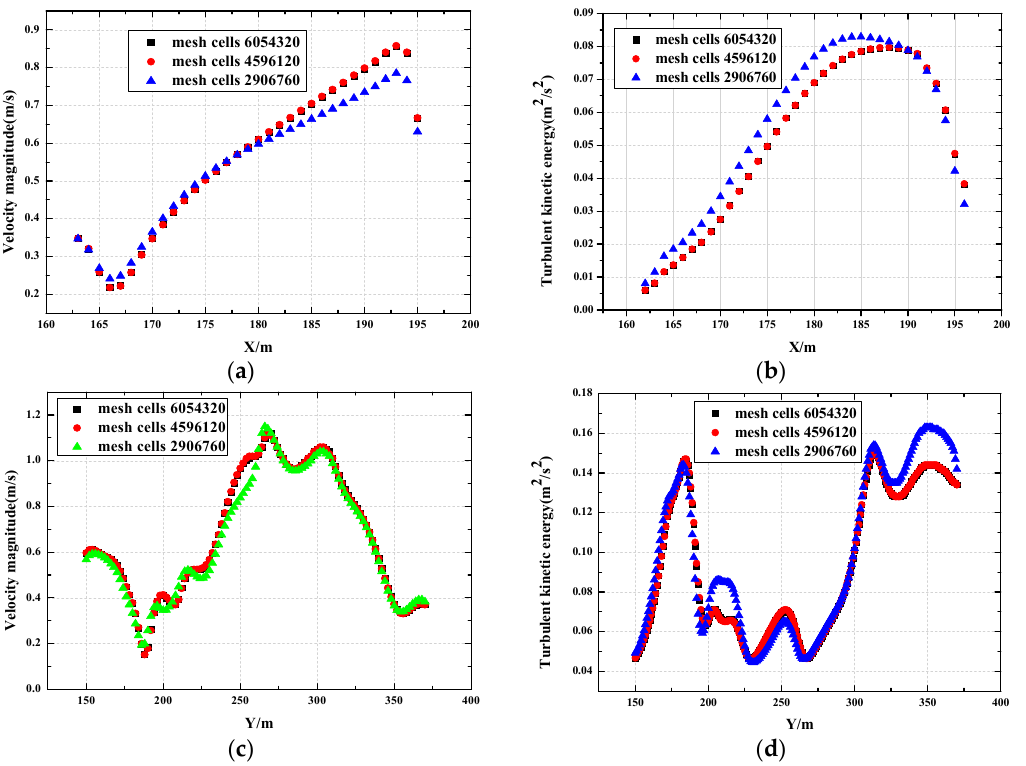
Figure 4. Velocity magnitude and turbulent kinetic energy profile at a height of 2 m along the Y = 160 m section and the street centerline. ( a ) velocity magnitude profile along the Y = 160 m section; ( b ) turbulent kinetic energy profile along the Y = 160 m section; ( c ) velocity magnitude profile along the street centerline; ( d ) turbulent kinetic energy profile along the street centerline.